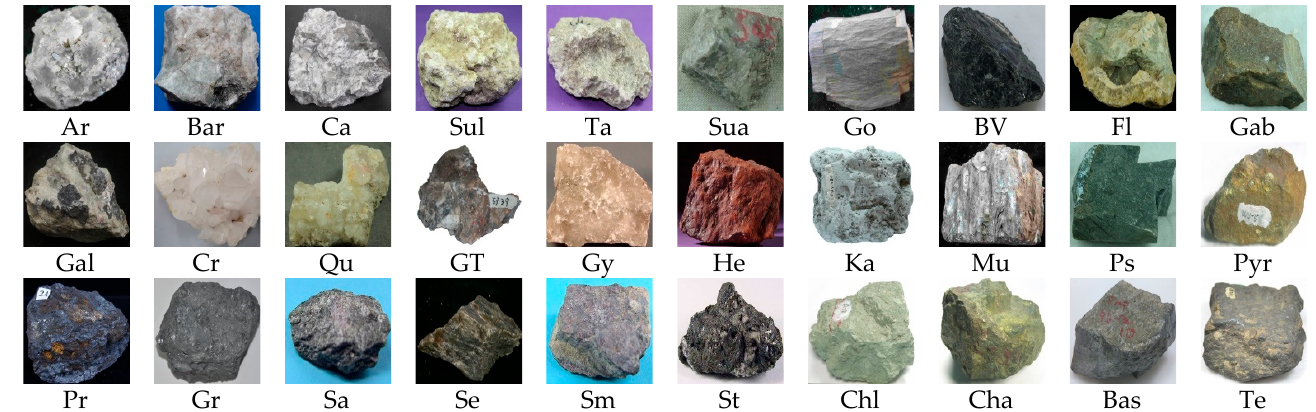
Figure 1. Instances of different types of rocks and samples in the laboratory. For abbreviation, muscovite (Mu), hematite (He), calcite (Ca), galena (Gal), kaolinite (Ka), talcum (Ta), pyrite (Pyr), chalcopyrite (Cha), gray tiemannite (GT), stibnite (St), gabbro (Gab), quartz (Qu), chlorite (Chl), serpentine (Se), smaltite (Sm), tennantite (Te), gypsum (Gy), graphite (Gr), crystal (Cr), suanite (Sua), aragonite (Ar), basalt (Bas), fluorite (Fl), psilomelane (Ps), saponite (Sa), goethite (Go), barite (Bar), sulfur (Sul), biotite vermiculite (BV), and pyroxenite (Pr).